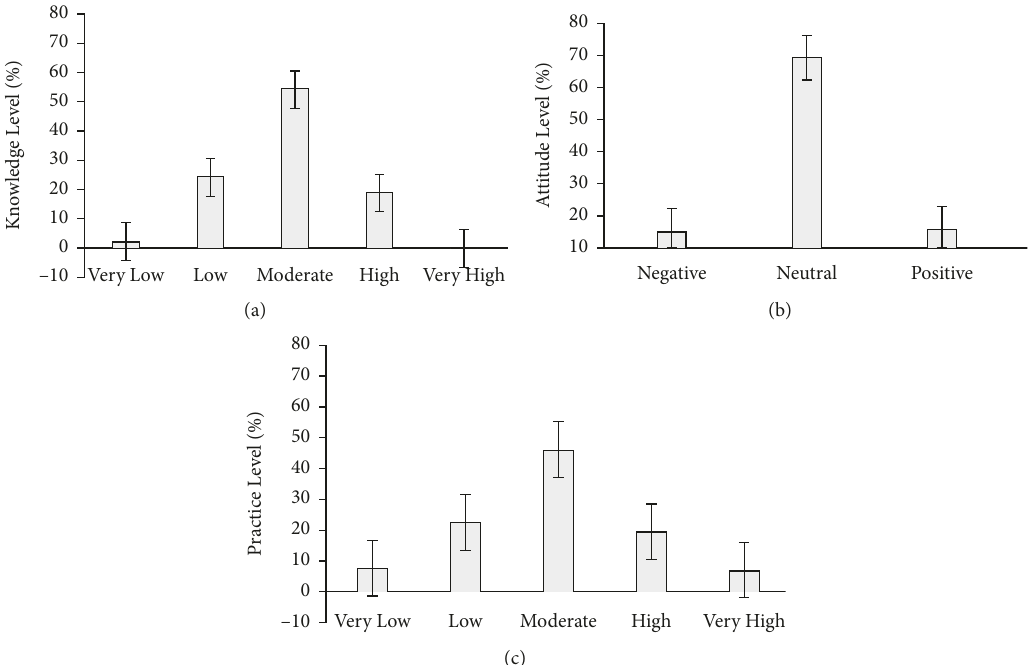
Figure 1: Caregivers’ (a) knowledge and (c) practice regarding prevention and care of pressure injuries (PIs) based on McDonald’s standard of learning outcome measure criteria: very low